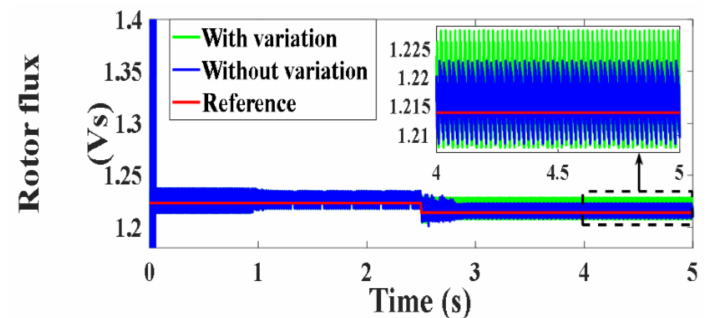
Figure 184. Rotor flux under PVC